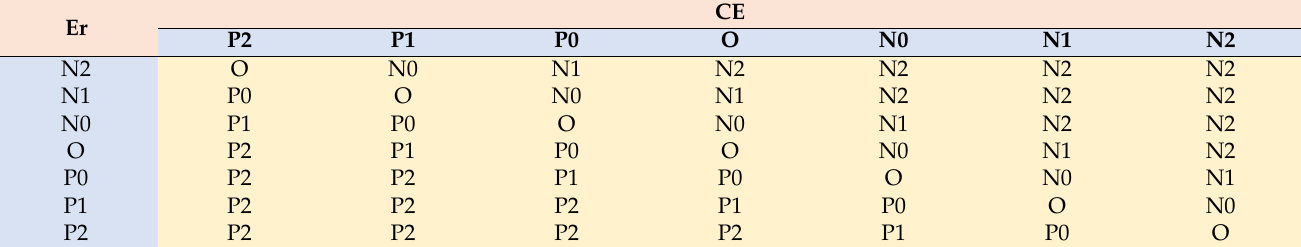
Figure 9. MF for “CE”. Table 4. MF mapping for capacitor voltage.